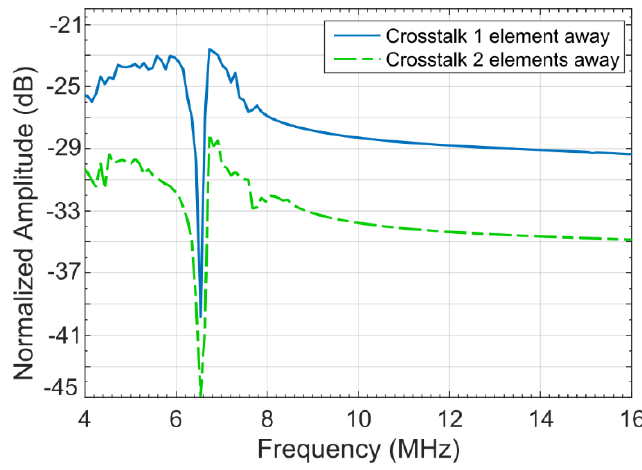
Figure 11. Crosstalk levels of an aerogel coated CMUT array [21]. Table 5. Crosstalk levels of the aerogel coated CMUT array [21].